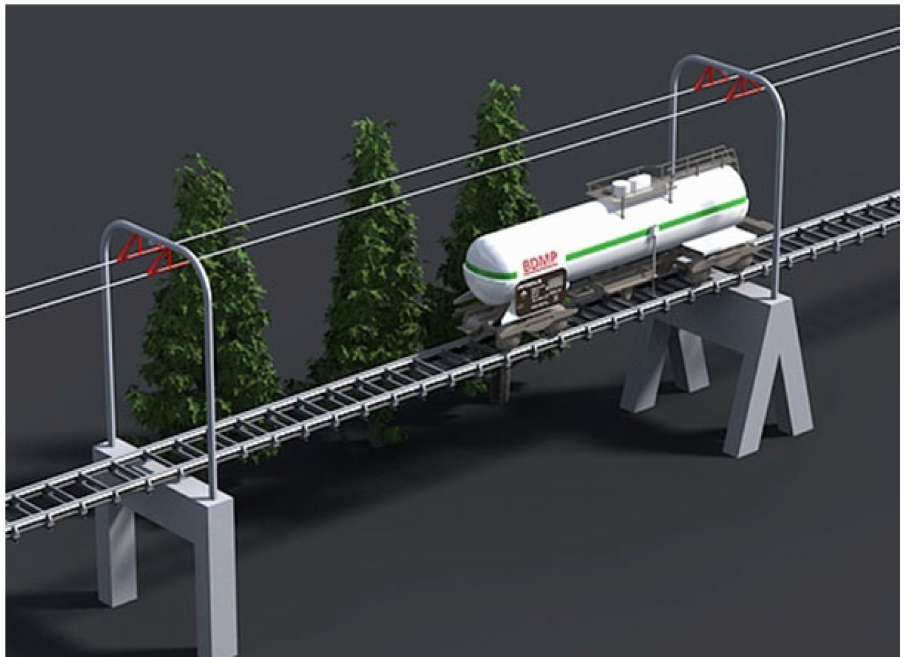
Figure 1. Schematic diagram of the typical structure of